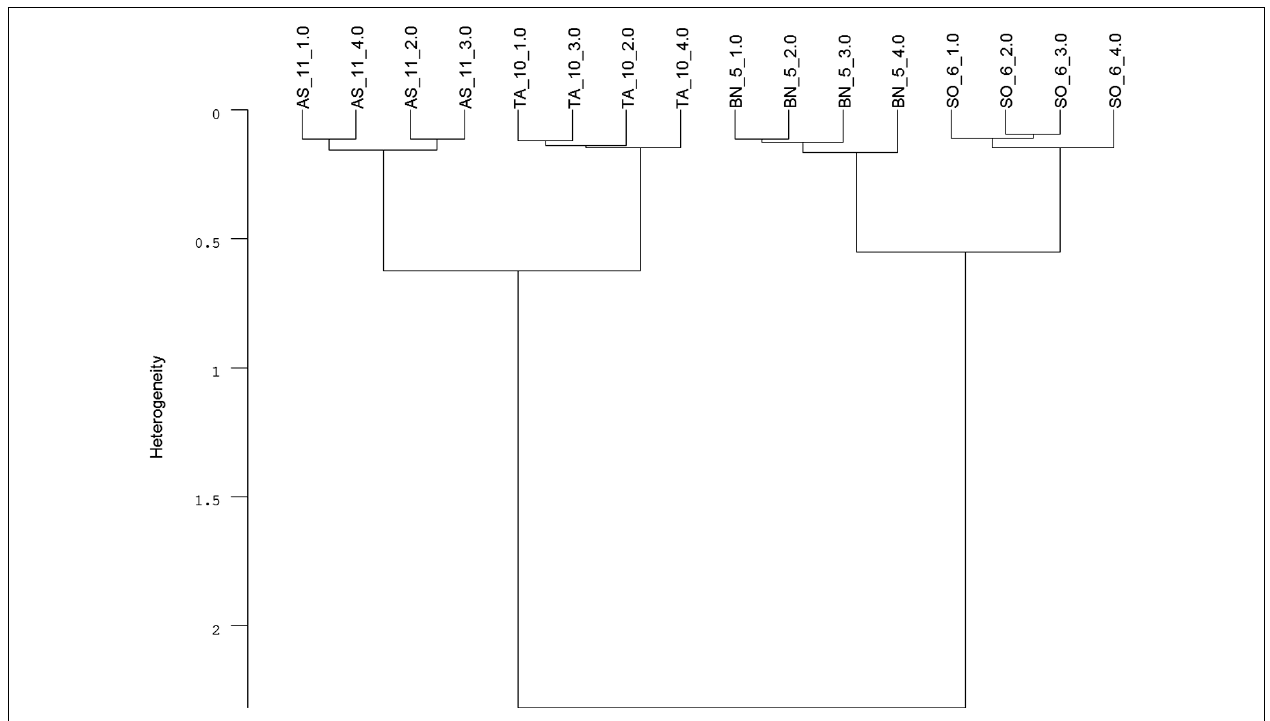
FIGURE 2 | Cluster analysis of FT-MIR–ATR spectra (Figure 1) recorded from dried, ground roots of Triticum aestivum (TA), Apera spica-venti (AS), Brassica napus (BN), and Sisymbrium officinale (SO) grown in a greenhouse experiment. Data were pre-processed